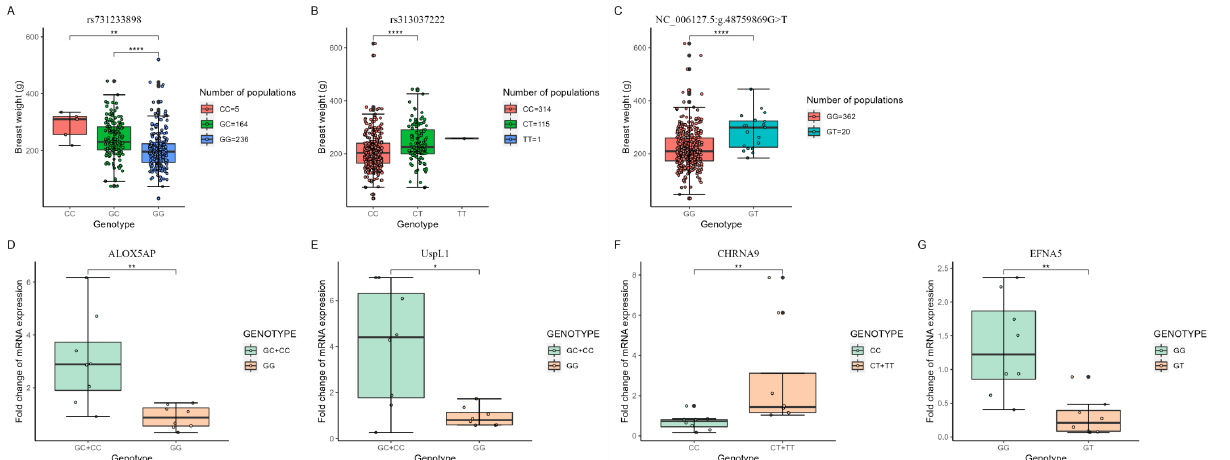
Figure 6. The breast muscle weight and expression levels of candidate genes in different genotypes. ( A – C ): The breast muscle weight of different genotypes. Vertical bars represent the mean ± standard error; ( D – G ): The expression levels of candidate genes in different genotypes. Vertical bars represent the mean ± standard error (n = 8). The scatter represents the sample distribution state around the mean. Statistically significant differences are indicated by * ( p < 0.05), ** ( p < 0.01), **** ( p <